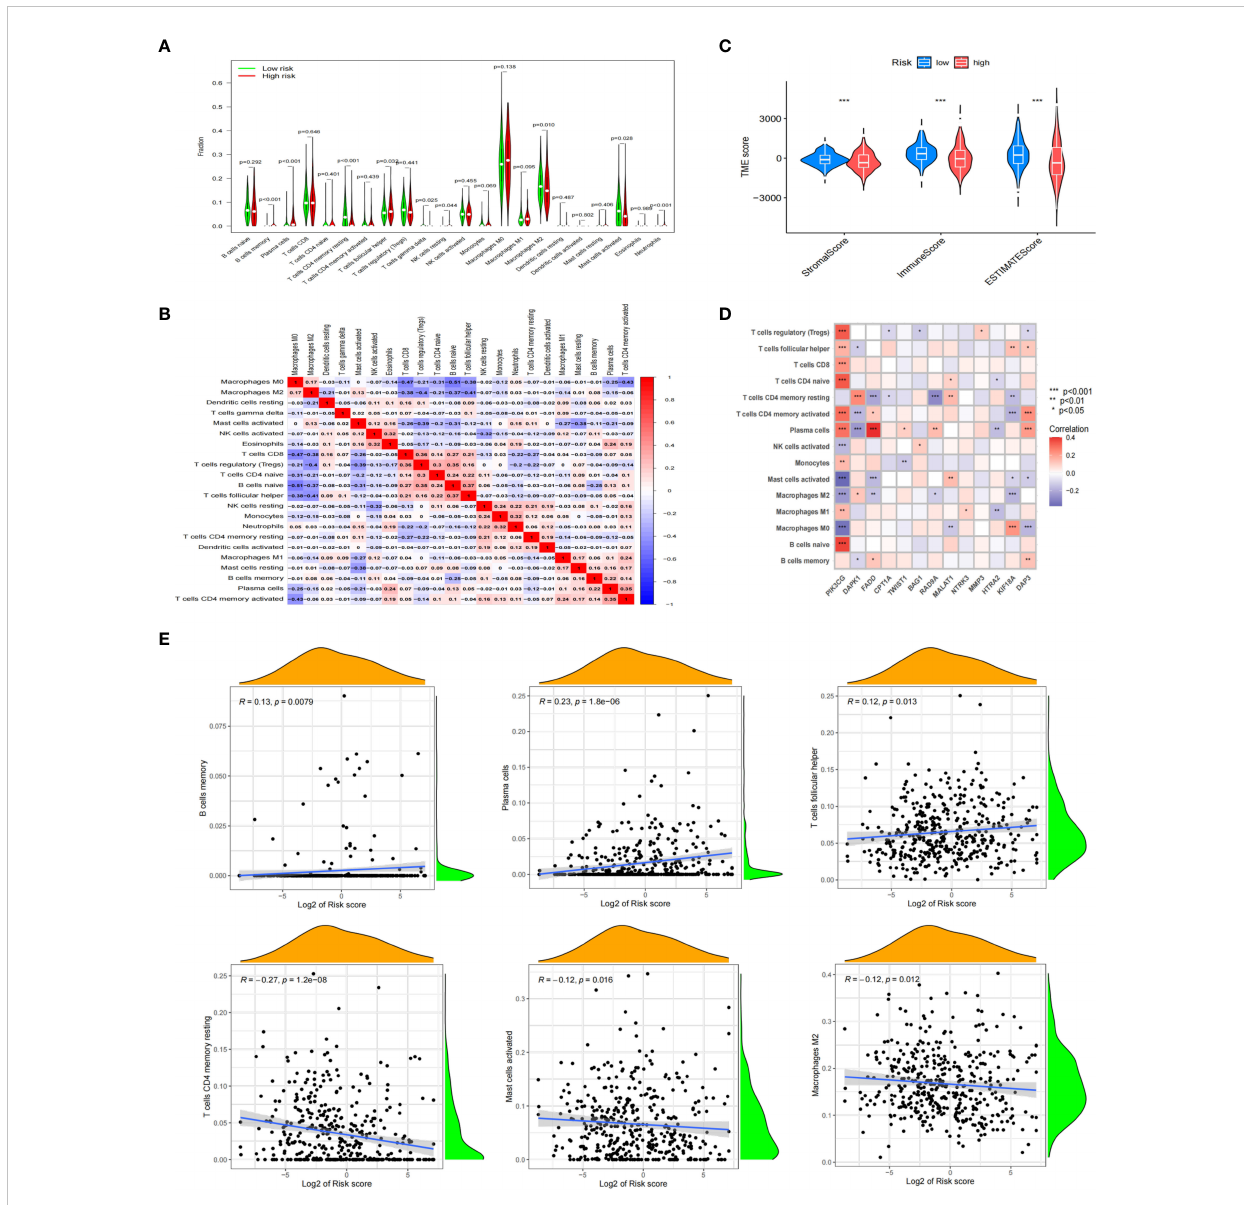
FIGURE 7 Correlation between immune cell status and different riskscores. (A) Analyzing the immune cell in fi ltration levels of NB samples from different anoikis-related risk groups by CIBERSORT algorithm. (B) Correlations between immune cells. (C) Differences of TME between different risk groups. (D) Analyzing the correlations between 15 Args participating in the model construction and immune cells. (E) Relationships between 6 kinds of immune cells and the riskscores of patients. *, p < 0.05; **, p < 0.01; ***, p <